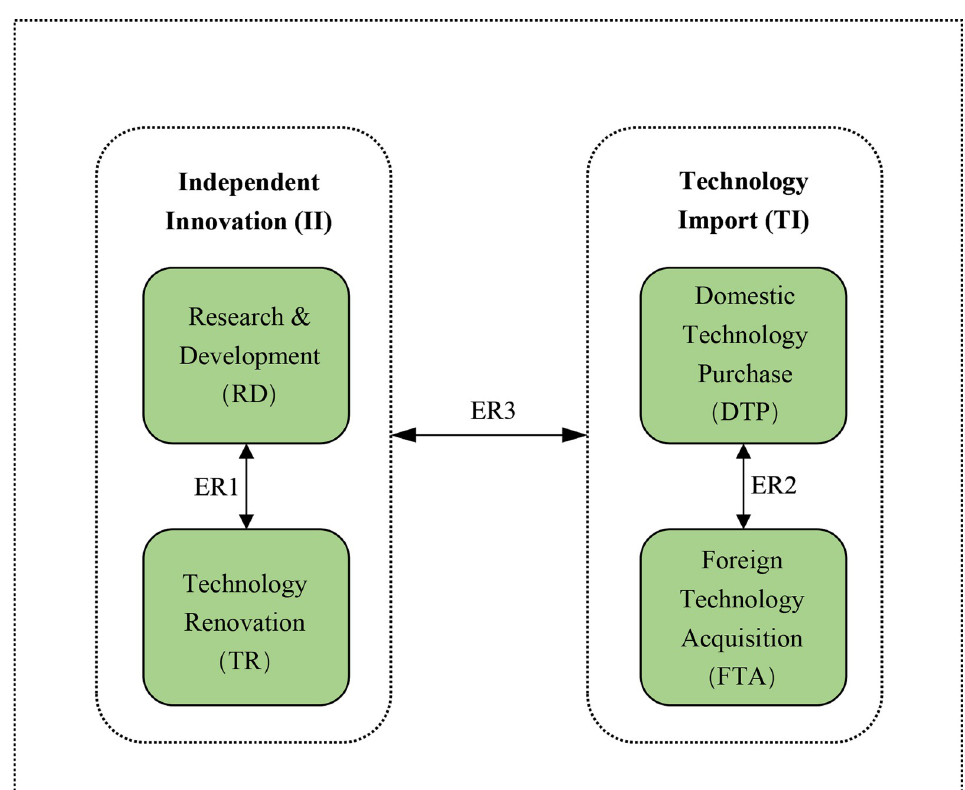
Fig 1. The research framework of the ecological relationships among six technology